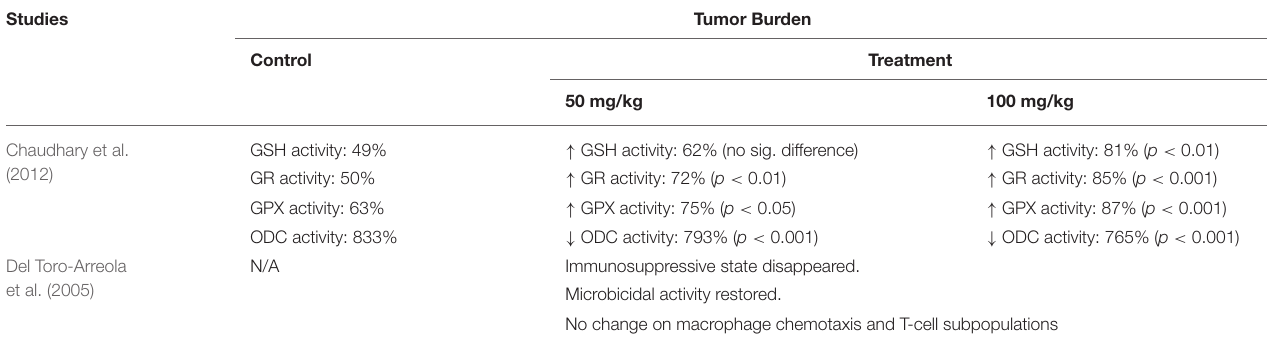
TABLE 5 | Studies investigating underlying mechanisms of the preventative effect of limonene on cancer development.